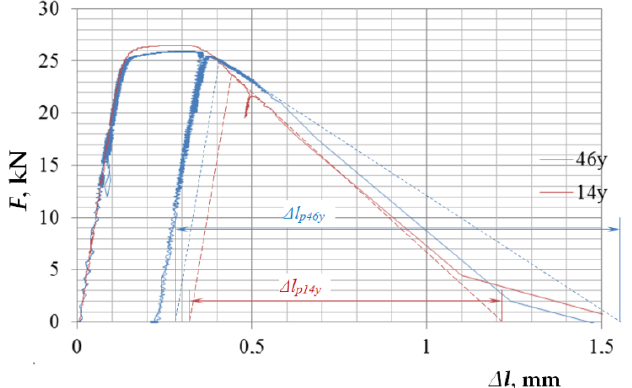
Figure 13. Complete stress-strain diagrams of specimens from the VT23M alloy in different states: 14y, in the initial state; 46, after DNP ( ε imp = 2.2%).